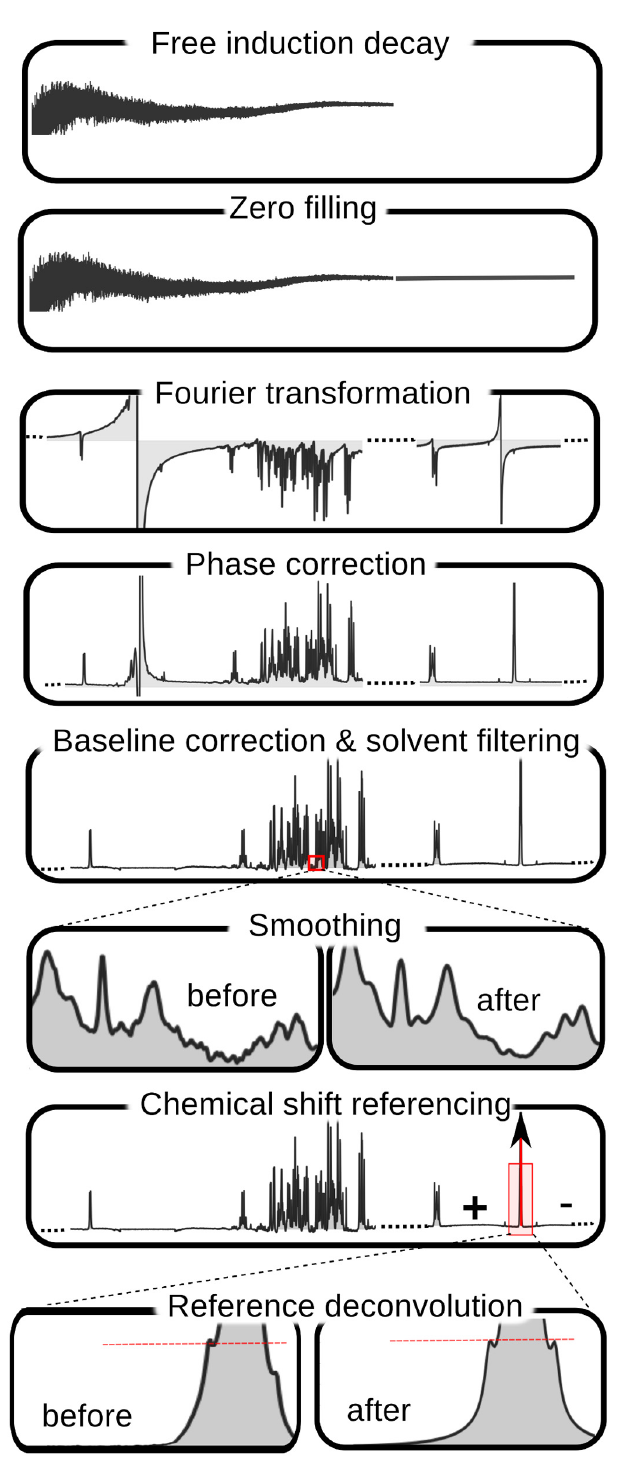
Fig 1. Spectral processing steps in Bayesil. Reference deconvolution and smoothing are optional. After baseline correction, Bayesil may go back to phase correction to re-adjust the phasing. For this, the imaginary part of the spectrum is reconstructed using Hilbert transformation (not